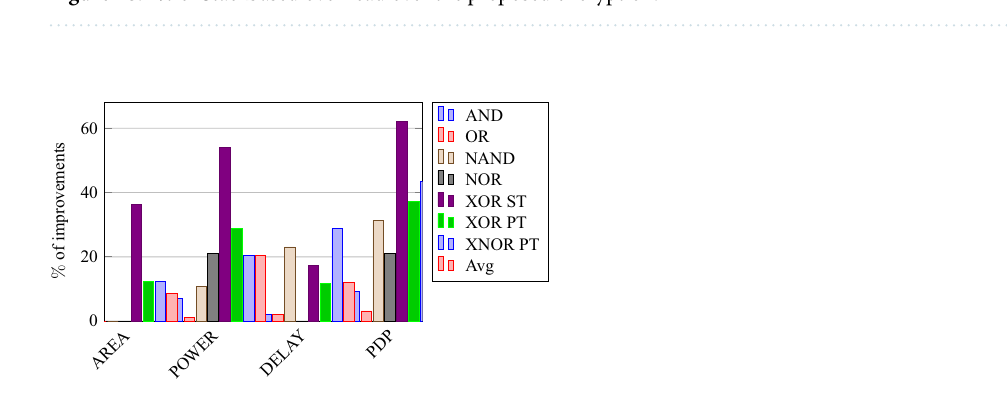
Figure 48. % of Stackbased overhead over the proposed encryption.